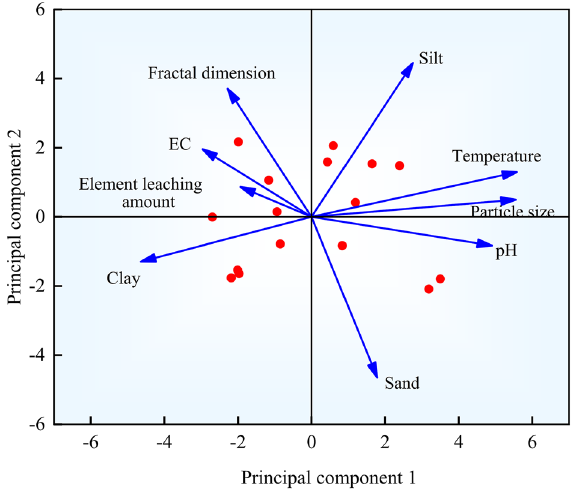
Figure 7. The principal component analysis diagram.